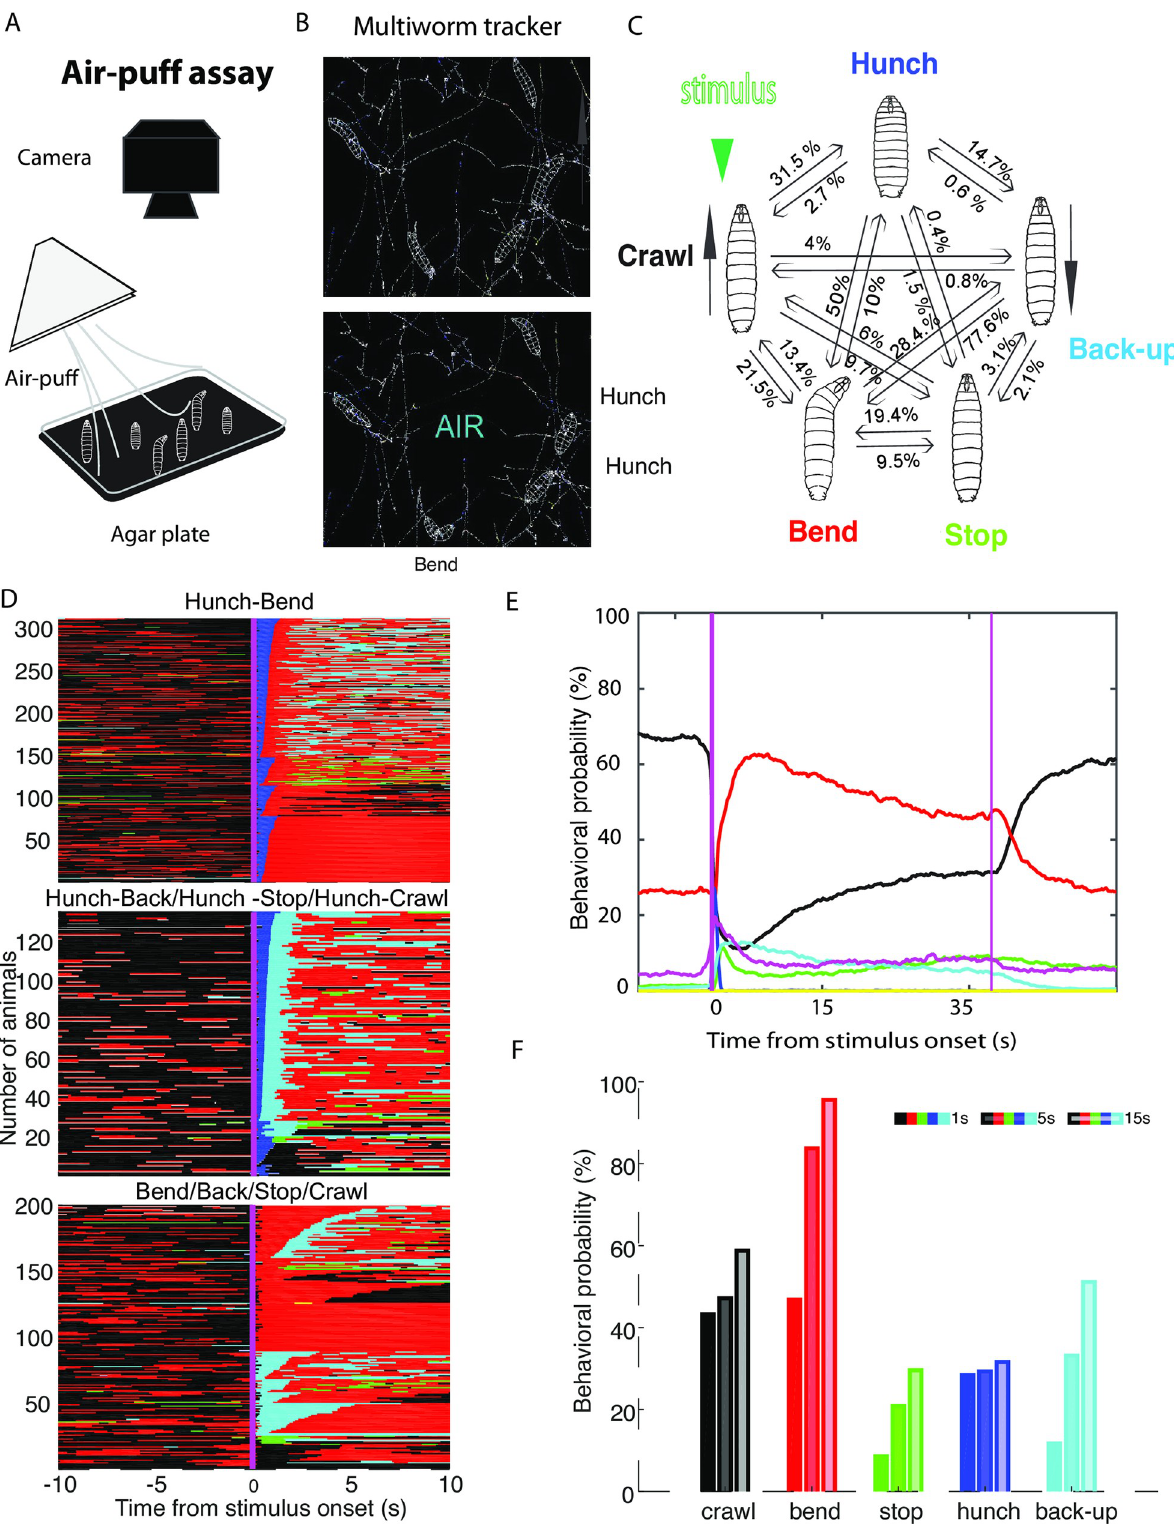
Fig 1. Characterization of the behavioral response of wild-type larvae to an air-puff. A. Behavioral set-up B . Still from a movie of contours of larvae acquired with the Multiworm tracker software C . In response to air-puff larvae perform a probabilistic sequence of five actions D . Ethogram